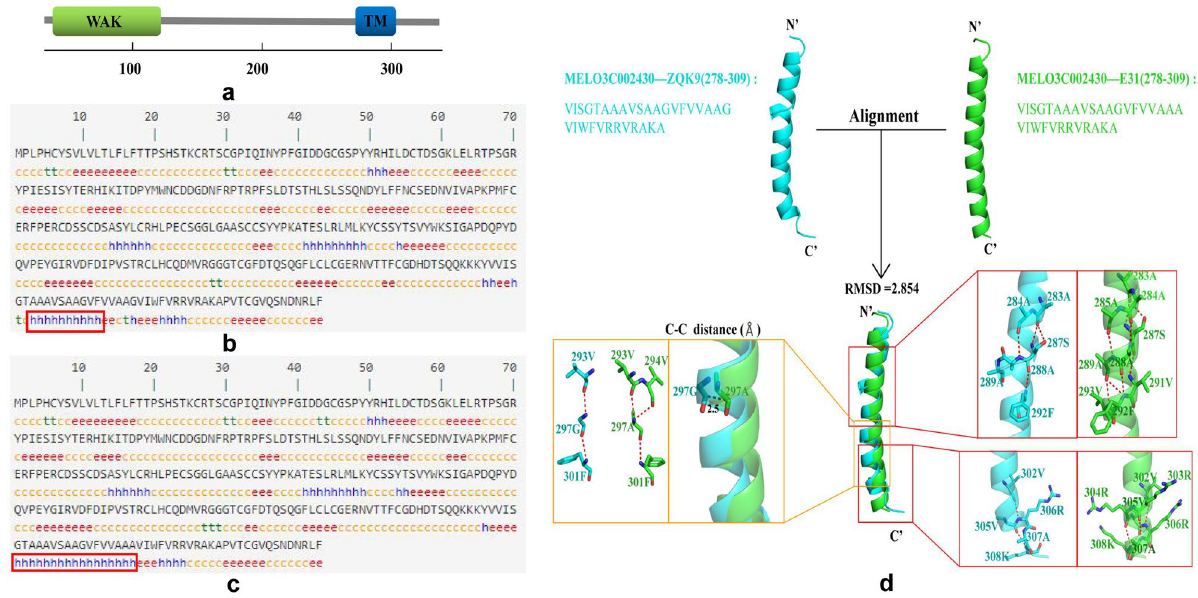
Figure 6. Protein structure analysis of MELO3C002430. ( a ) Domain region of the protein. WAK, wall- associated receptor kinase; TM, transmembrane region. ( b , c ) Secondary structure of the protein in ZQK9 and E31, respectively. h, alpha helix; e, extended strand; t, beta turn; c, random coil. Red boxes indicate the alpha helixes with different number in MELO3C002430 protein of ZQK9 and E31. ( d ) The difference of the protein tertiary structure in the mutation region generated by PyMOL molecular graphic system version 2.4 (https :// pymol .org/2/). Red dotted line represents the hydrogen